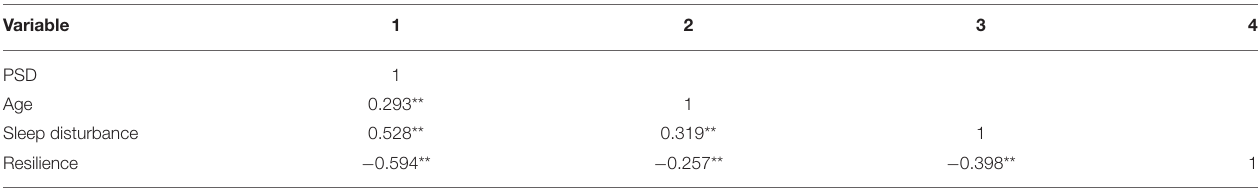
TABLE 2 | The Pearson correlation among age, sleep disturbance, resilience, and PSD.